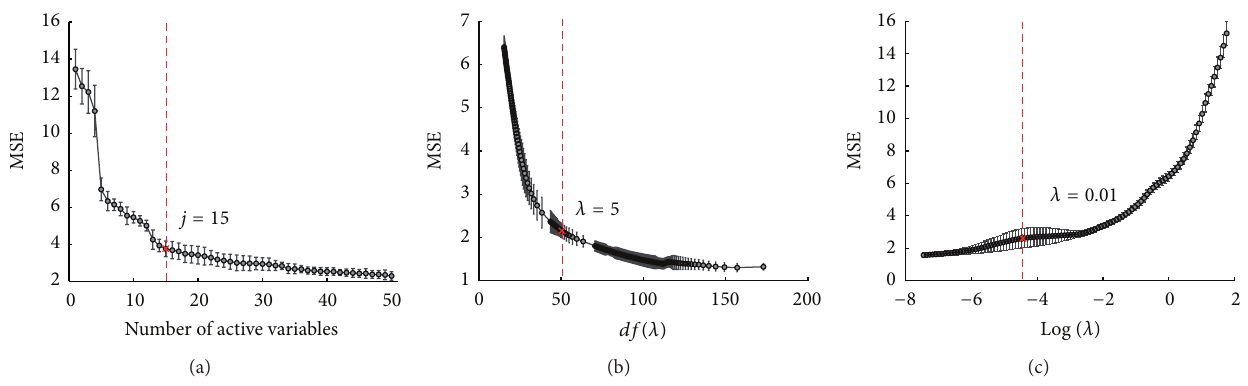
Figure 2: 10-fold cross-validation curves for the choice of the “optimal” complexity parameters for LASSO (a), Ridge (b), and EN for 𝛼 = 0.4 (c). The MSE (mean value and one standard deviation) is represented as a function of the model complexity parameter for each method. The red crosses represent the values of the complexity parameter chosen according to the drop in the error curve. The vertical red dashed line is for a better visual identification of the complexity